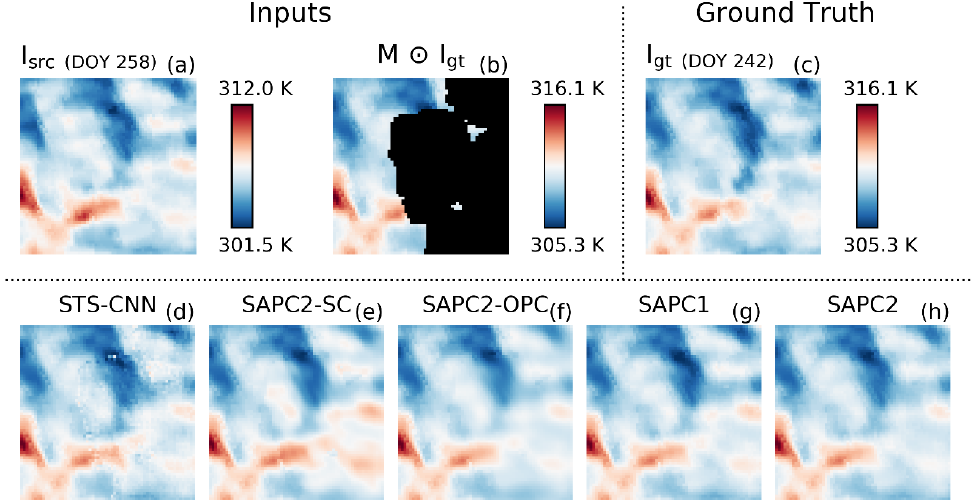
Figure 12. The same as Figure 9 but for Case 4 (acquisition DOYs for source and target inputs are 258 and 242, respectively). The masked fraction of the target image ( b ) is 0.549. The correlation coe ffi cient between source ( a ) and ground truth ( c ) images is